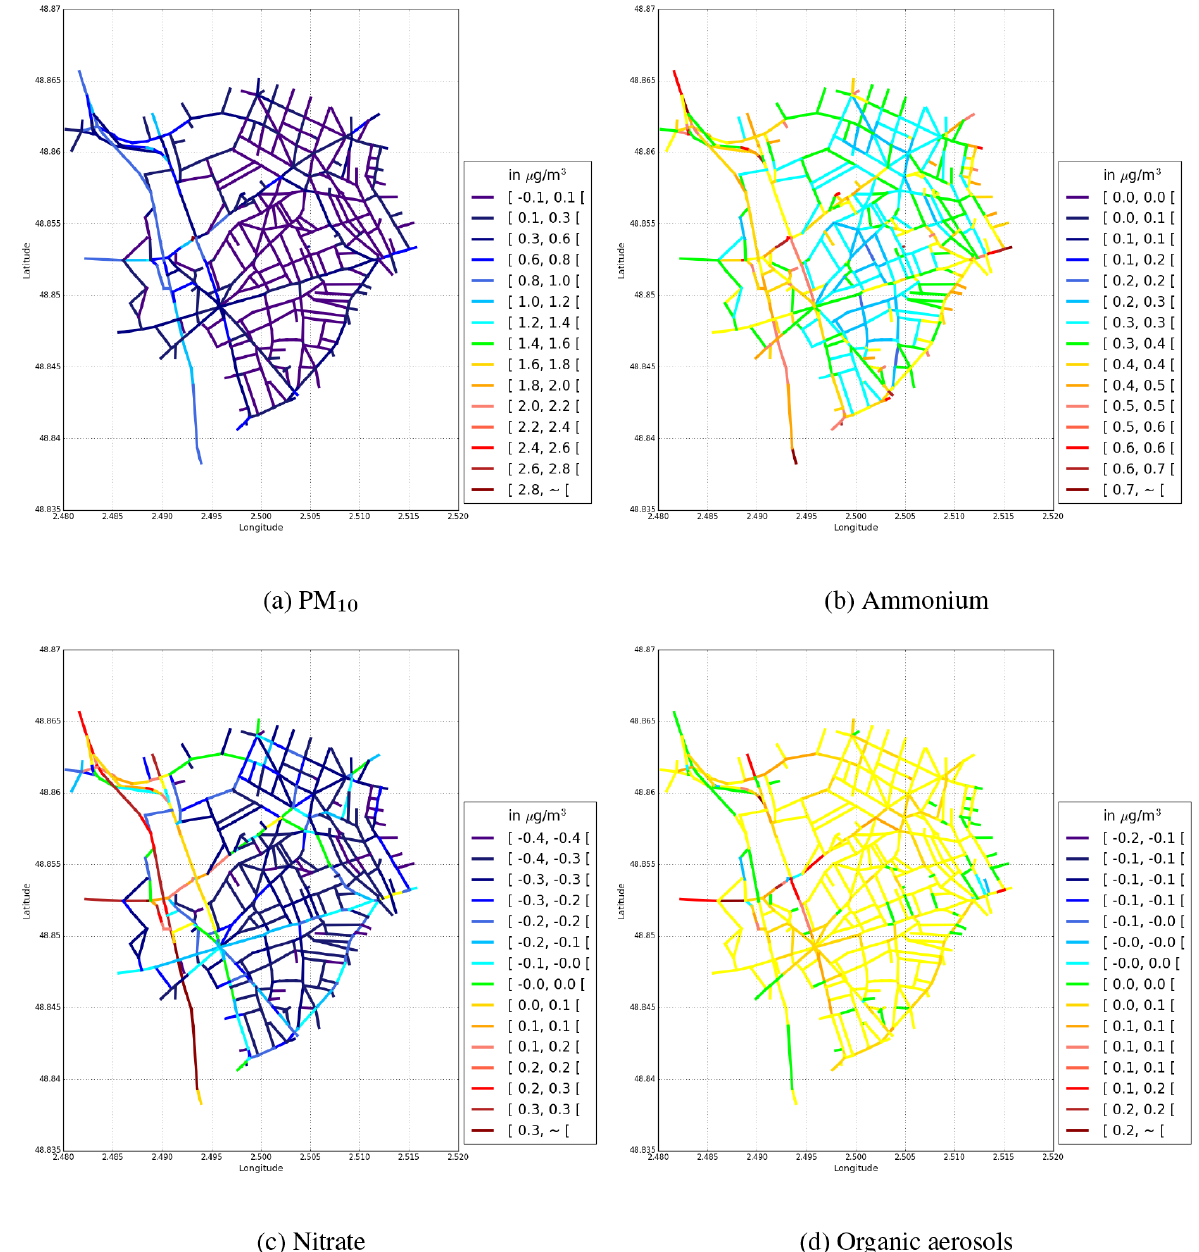
Figure C3. Differences in time-averaged concentrations (in µgm − 3 ) between Case-5 and Case-1 (Case-5 − Case-1) for (a) PM 10 , (b) am- monium, (c) nitrate, and (d) organic